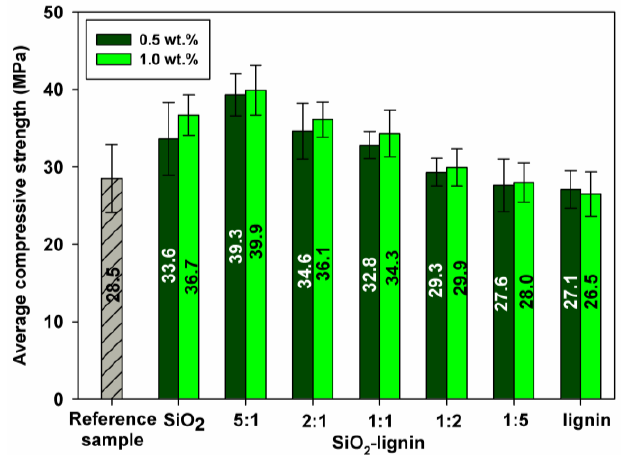
Figure 7. Compressive strength analysis of cement pastes with the silica, lignin and silica-lignin hybrid materials with different weight ratios of the components used.